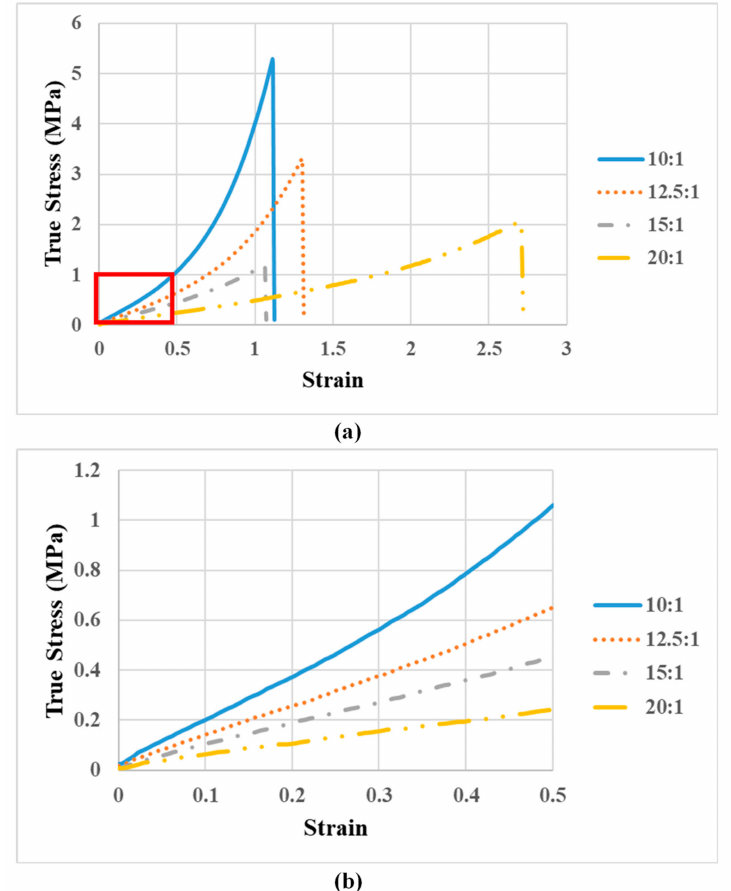
Figure 7. ( a ) The tensile test results of specimens fabricated using di ff erent ratios of silicone base and hardener (10:1 to 20:1); ( b ) enlarged area of ( a ), and the Young’s Modulus corresponding to di ff erent ratios was estimated from the slopes of each